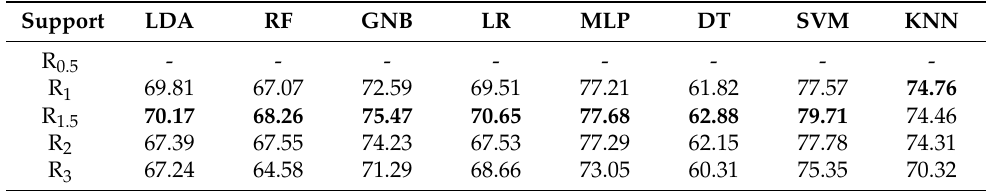
Figure 9. Classified point cloud with the highest accuracy ( left ) and with lowest accuracy ( right ) in the Vaihingen dataset. Table 5. The overall accuracy of the methods in Vaihingen. The highest-obtained accuracies are shown as